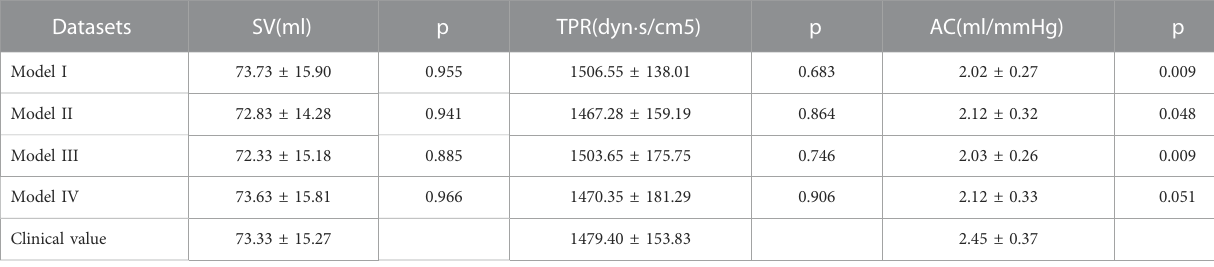
TABLE 1 Comparison calculation and clinical measurements value of SV, TPR, and AC.